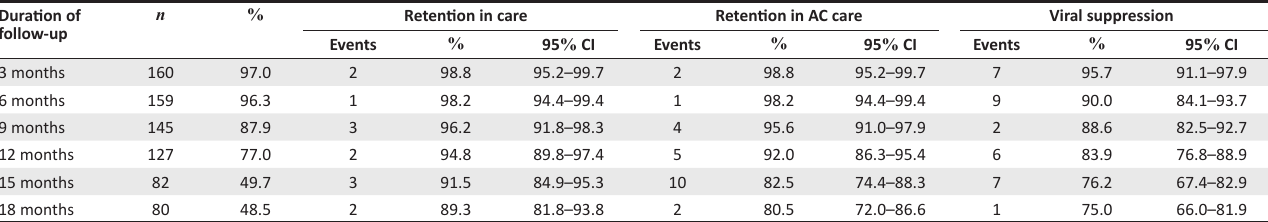
FIGURE 2: Retention in care (a), retention in adherence club care (b) and viral suppression (c) over the first 18 months in adherence clubs immediately after viral suppression and referral to an adherence TABLE 2: Kaplan–Meier estimates of retention in care, retention in adherence club care and viral suppression by duration of follow-up after first AC meeting.